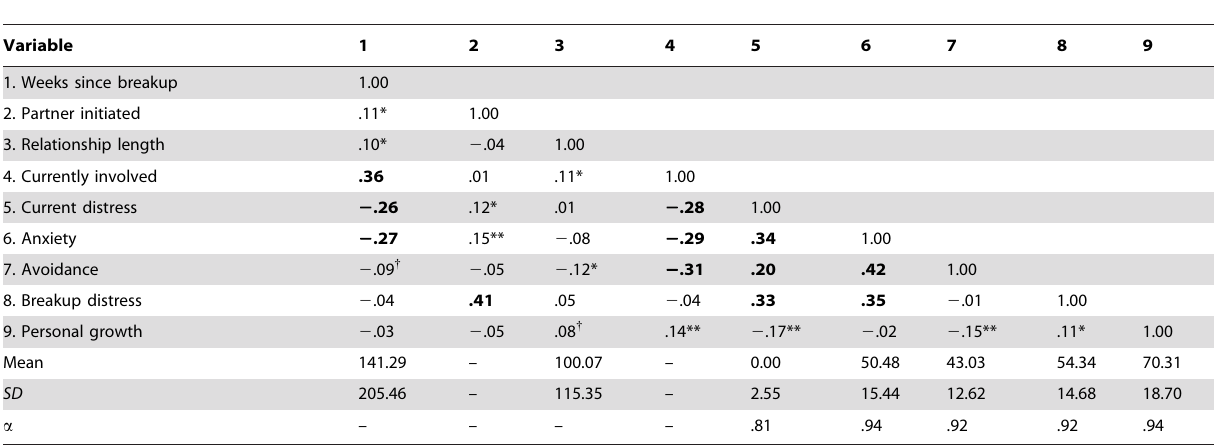
Table 1. Study 1: Pearson’s correlations, descriptive statistics, and reliability coefficients.